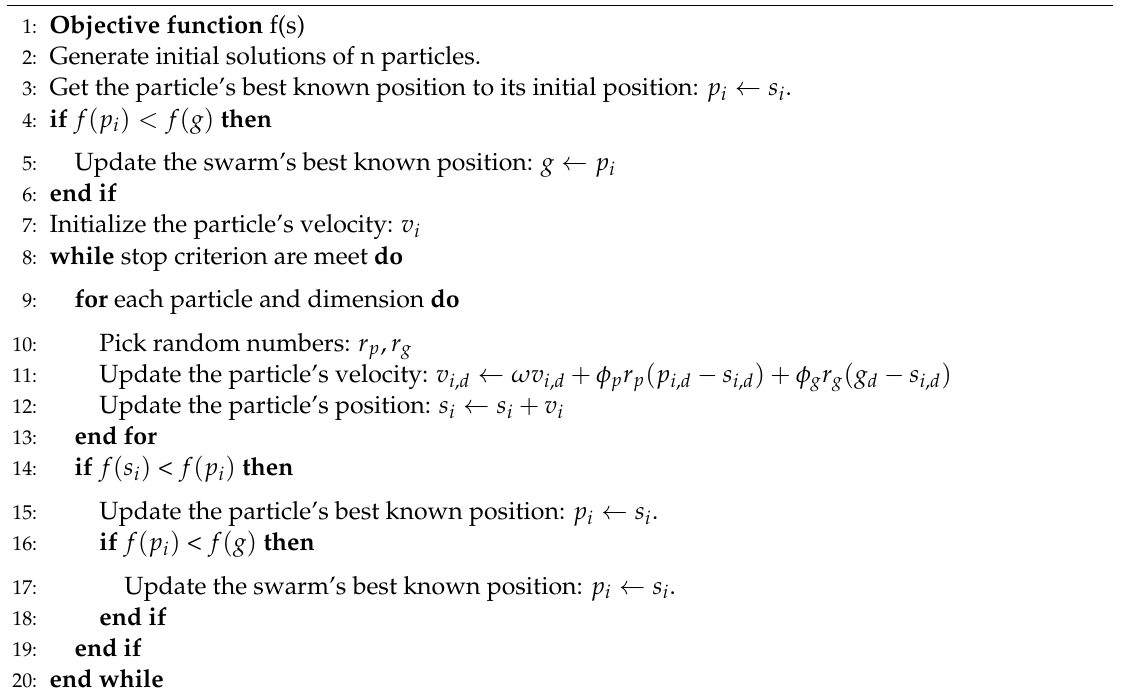
Algorithm 1 Particle swarm optimization